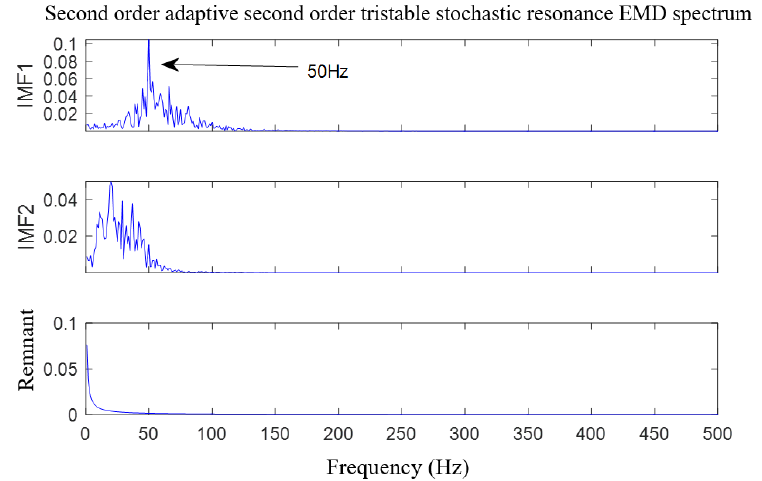
Figure 11. The processing results of the second-order stochastic resonance output.